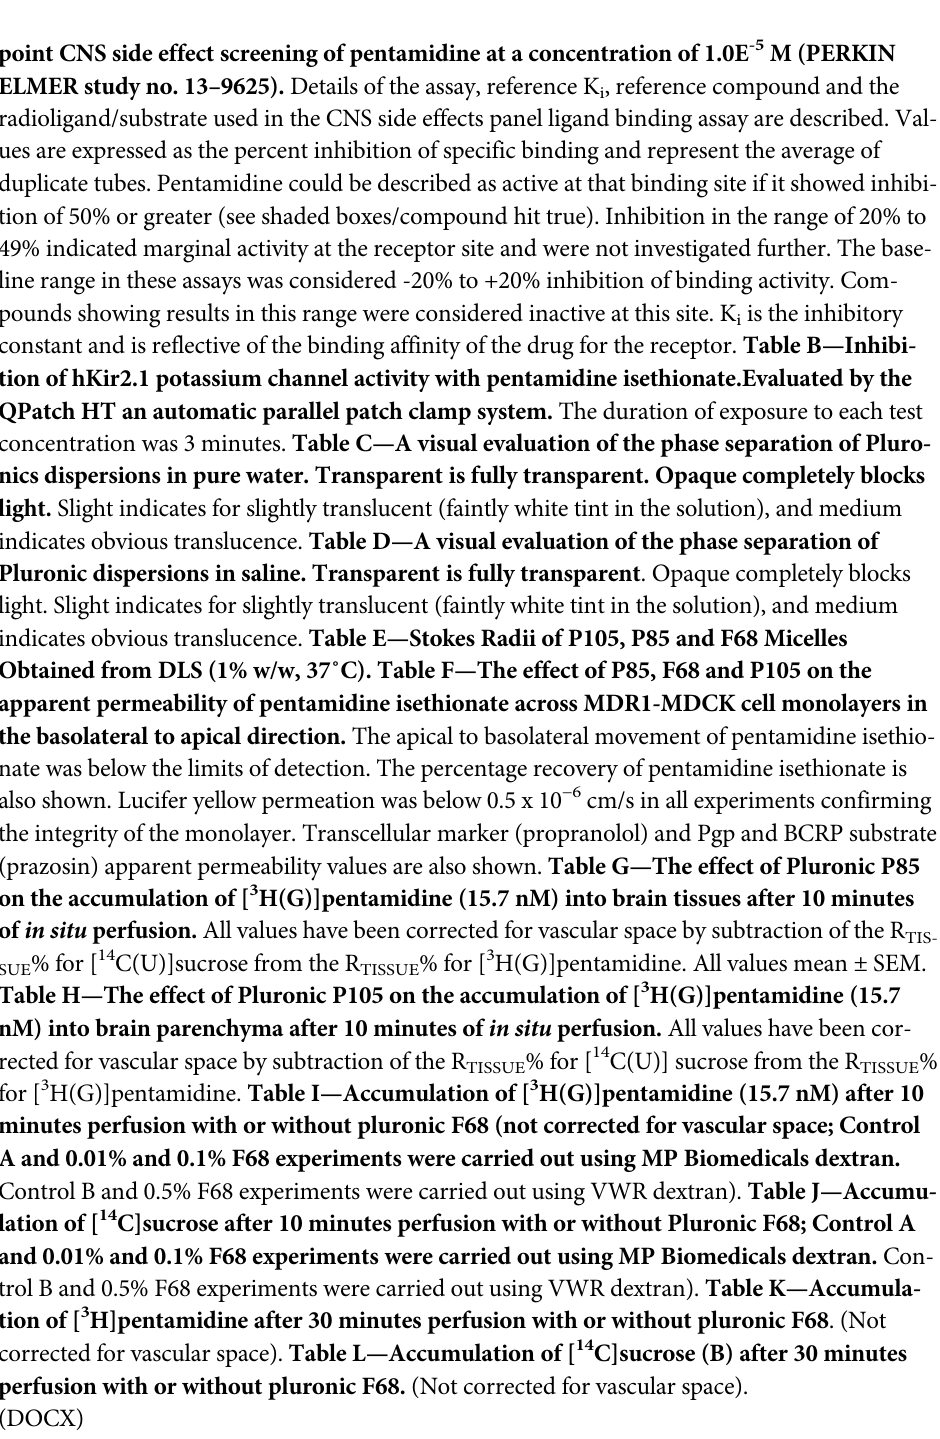
Table H—The effect of Pluronic P105 on the accumulation of [ 3 H(G)]pentamidine (15.7 nM) into brain parenchyma after 10 minutes of in situ perfusion. All values have been cor- rected for vascular space by subtraction of the R % for [ 14 C(U)] sucrose from the R % TISSUE TISSUE for [ 3 H(G)]pentamidine. Table I—Accumulation of [ 3 H(G)]pentamidine (15.7 nM) after 10 minutes perfusion with or without pluronic F68 (not corrected for vascular space; Control A and 0.01% and 0.1% F68 experiments were carried out using MP Biomedicals dextran. Control B and 0.5% F68 experiments were carried out using VWR dextran). Table J—Accumu- lation of [ 14 C]sucrose after 10 minutes perfusion with or without Pluronic F68; Control A and 0.01% and 0.1% F68 experiments were carried out using MP Biomedicals dextran. Con- trol B and 0.5% F68 experiments were carried out using VWR dextran). Table K—Accumula- tion of [ 3 H]pentamidine after 30 minutes perfusion with or without pluronic F68 . (Not corrected for vascular space). Table L—Accumulation of [ 14 C]sucrose (B) after 30 minutes perfusion with or without pluronic F68. (Not corrected for vascular